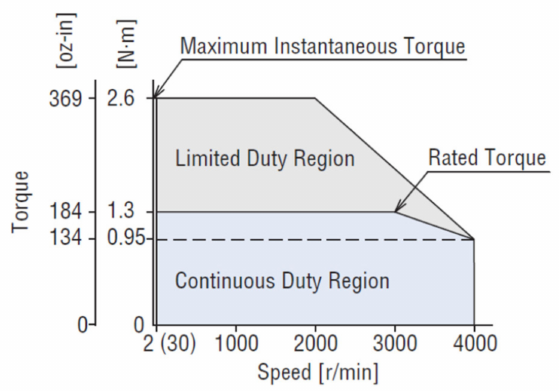
Figure 7. Speed-torque characteristics for the BXM6400M-A-3